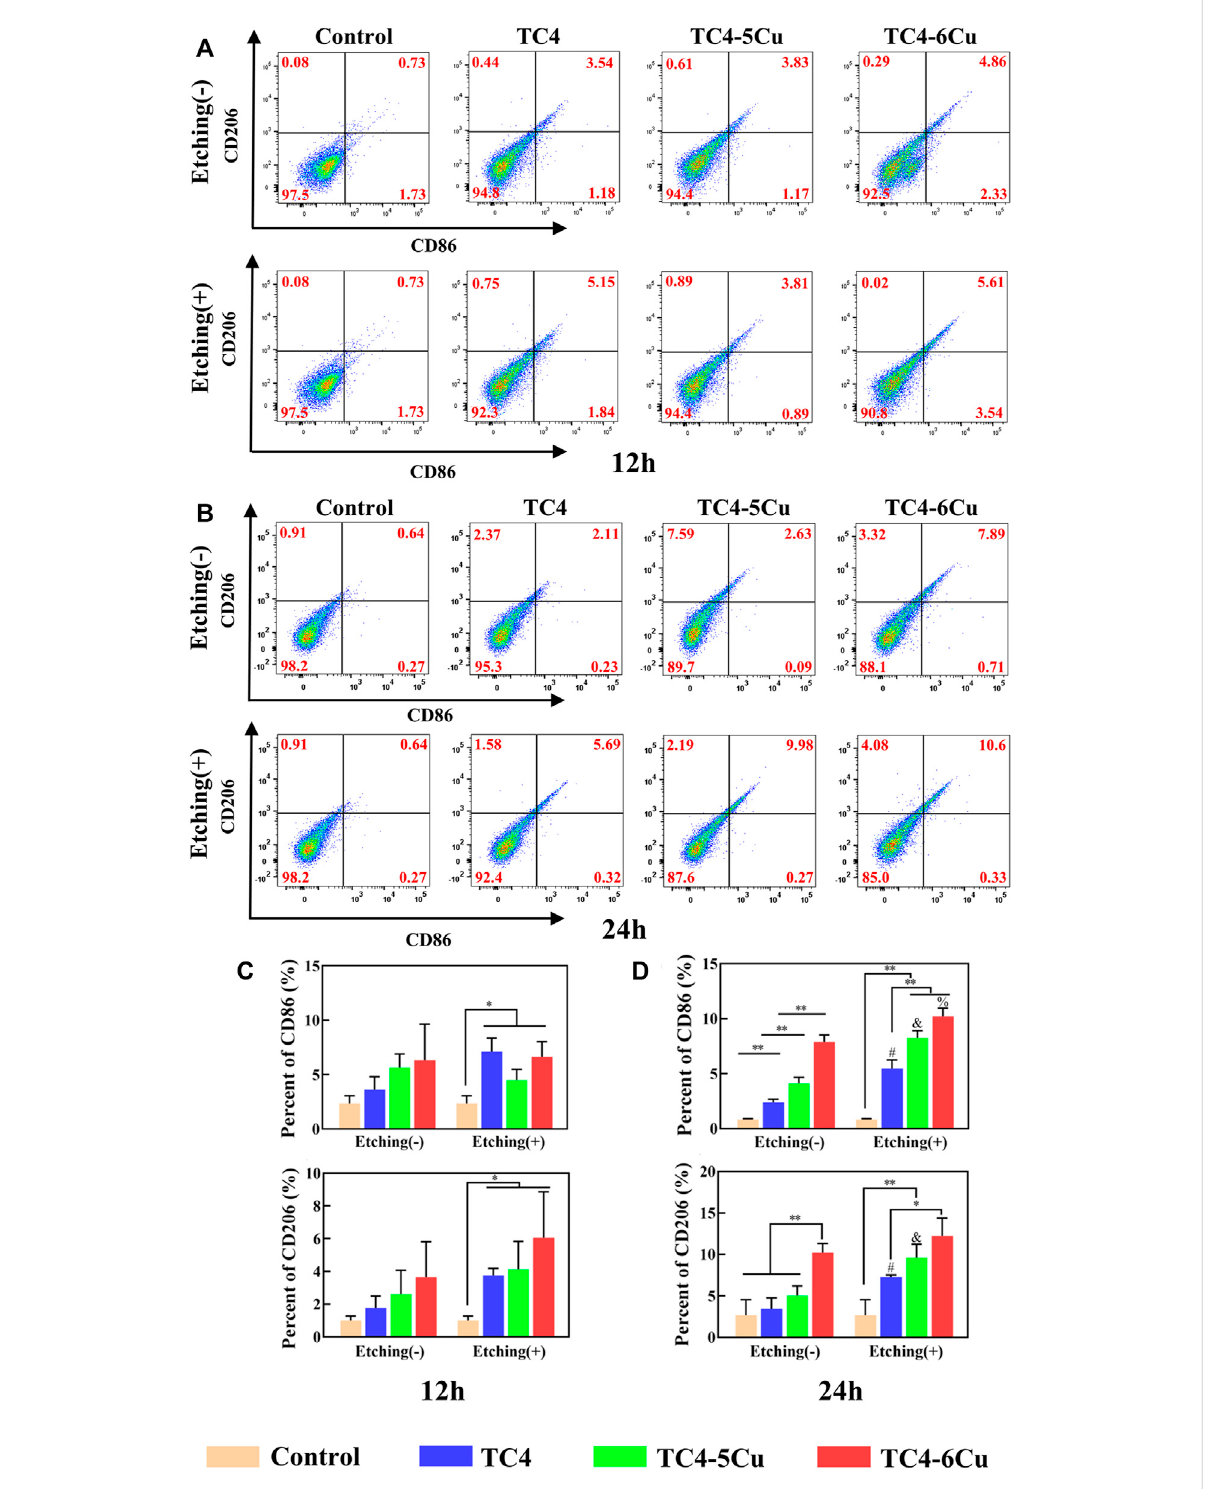
FIGURE 7 Flow cytometry analysis of RAW 264.7 cell surface markers cultured in different alloy extracts for 12 and 24 h (A,C) Expression of CD86 and CD206 in different alloy extracts for 12 h; (B,D) expression of CD86 and CD206 in different alloy extracts for 24 h (NS: No signi fi cant difference; * p < 0.05; ** p < 0.01; #, compared with TC4 alloy, p < 0.05; and, compared with TC4-5Cu alloy, p < 0.05; %, compared with TC4-6Cu alloy, p <